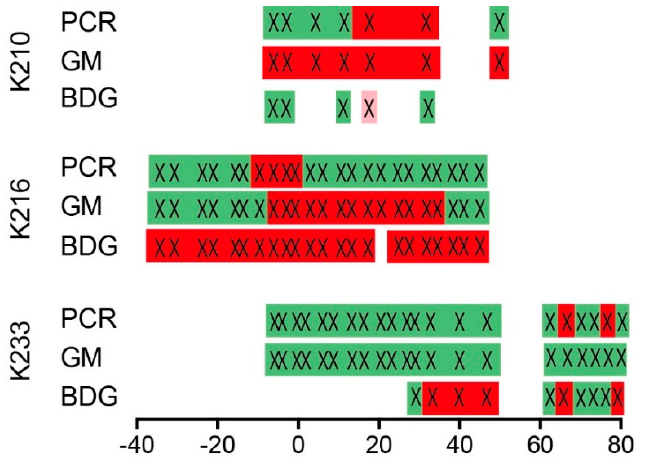
Figure 2. Temporal correlation of positive biomarkers (PCR, GM and BDG) in probable IA patients. The scale represents days in correlation to positive high resolution computed tomography (HRCT) scan; positive tests are indicated by crosses on red background. Green background indicates negative tests. Light red background (K210, BDG) indicates a serum with an indeterminate BDG result: 60–79 pg/mL; negative numbers indicate time before HRCT.